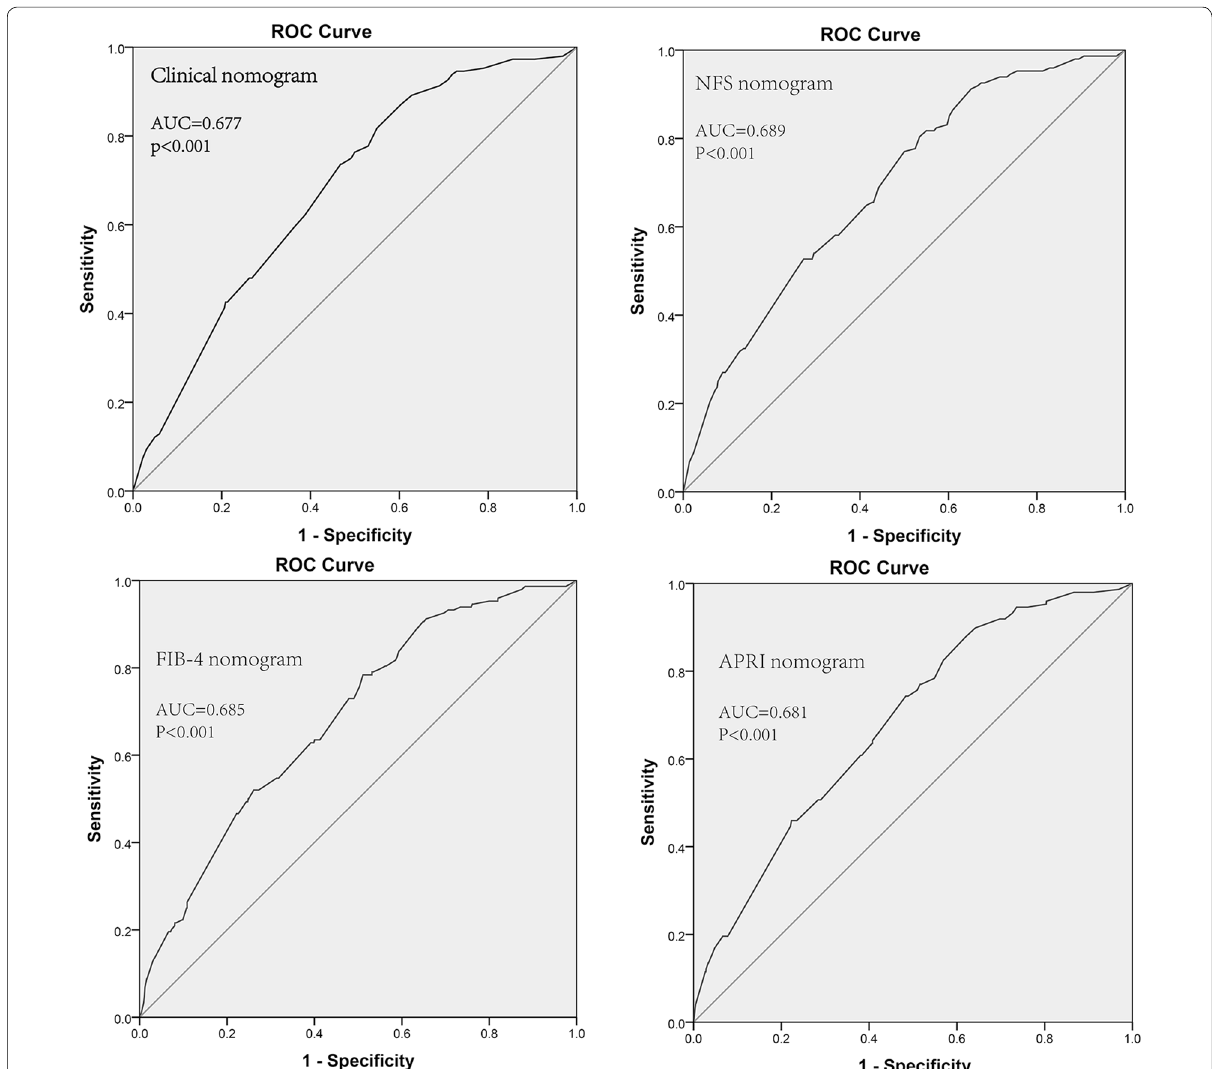
Fig. 2 Liver fibrosis score nomogram measured by ROC curves for DFS in the discovery cohort. AUC area under the curve, ROC receiver operator characteristic. Among NFS, FIB4 and APRI, NFS did the best